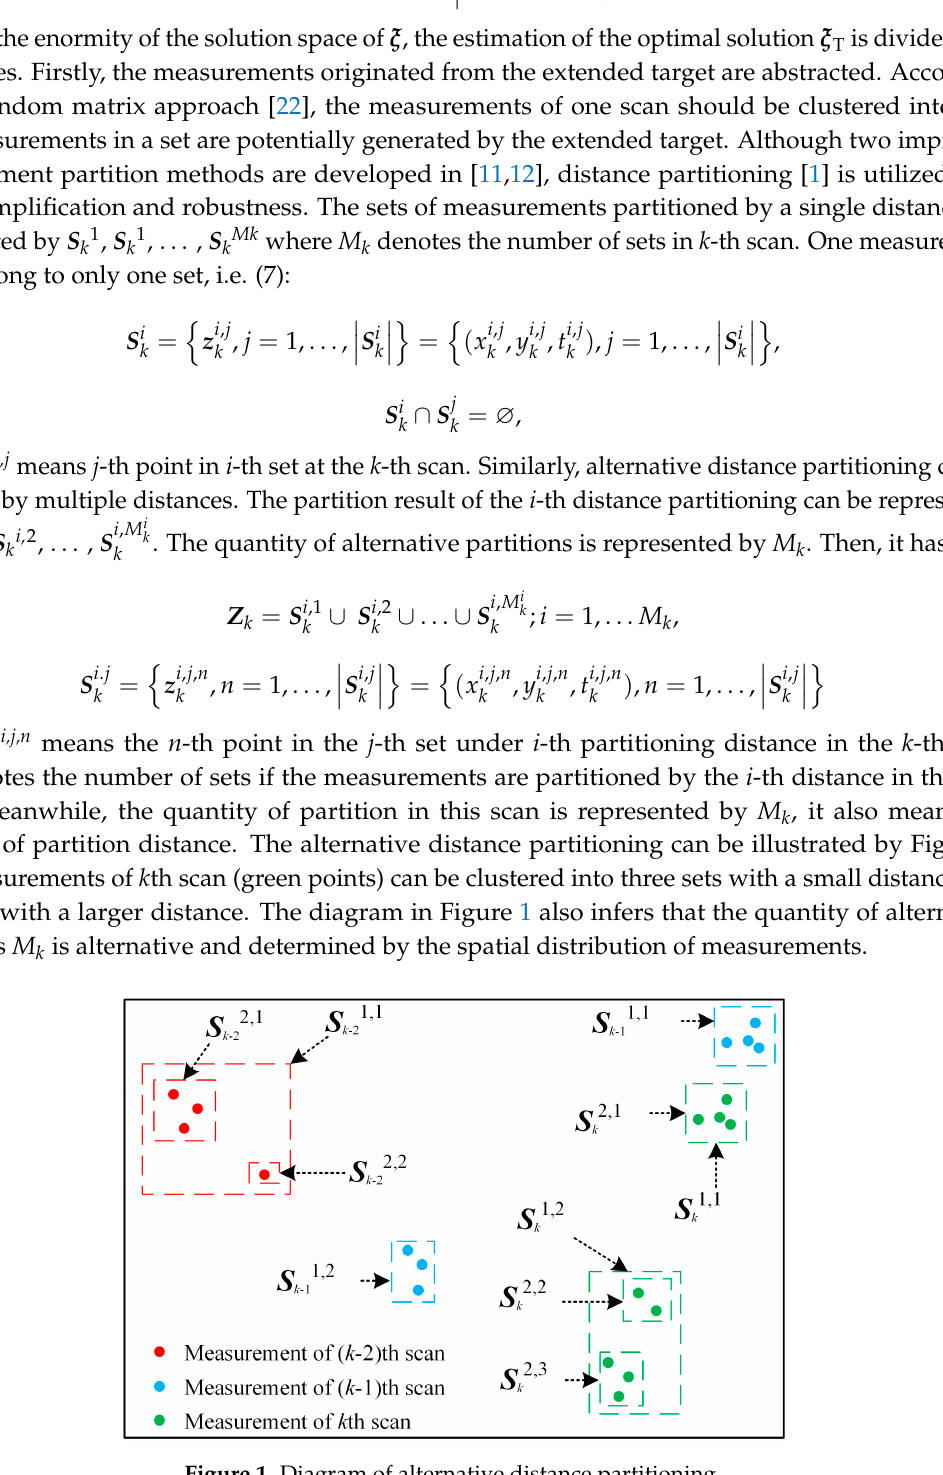
Figure 1. Diagram of alternative distance partitioning.